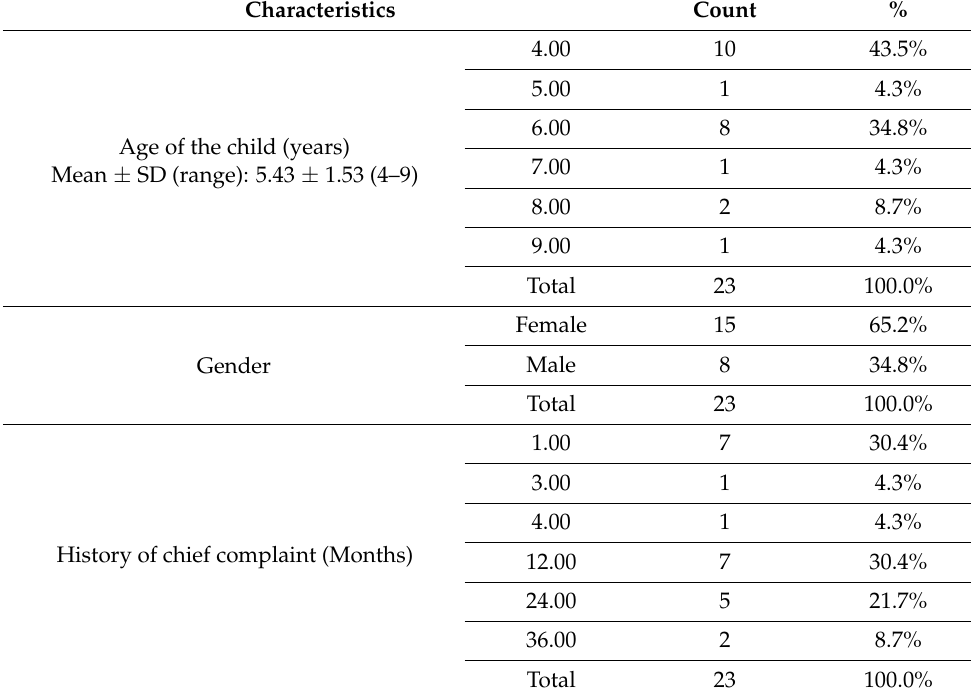
Table 2. Descriptive data and characteristics of study of